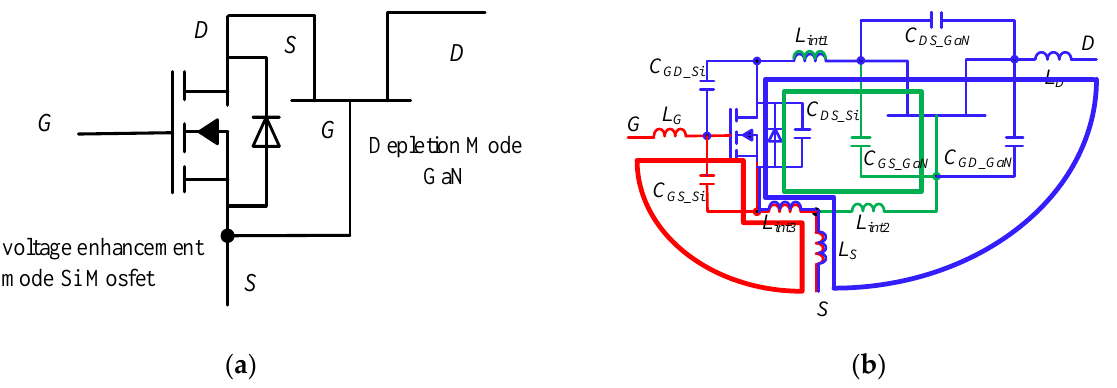
Figure 1. Configuration and equivalent circuit of cascode GaN HEMT. ( a ) The internal structure of the cascode GaN HEMT; ( b ) The equivalent diagram of the cascode GaN HEMT considering the parasitic inductors.